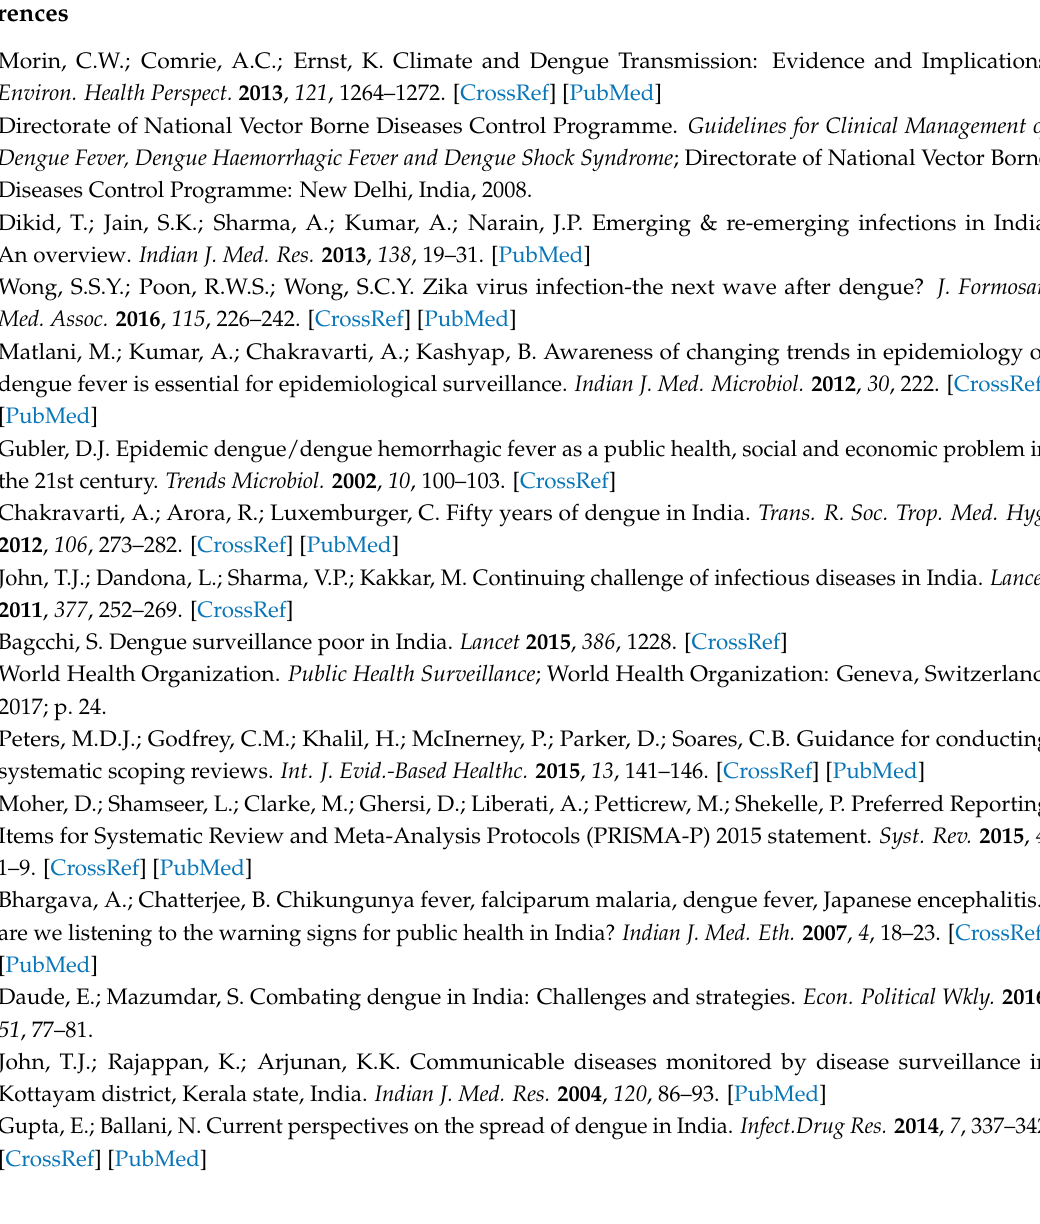
Table S1: Search word and MeSH term overview linked to databases used for review, Table S2: Inclusion and exclusion criteria of literature review, Table S3: The literature review summary of organization, implementation and functioning of dengue surveillance in